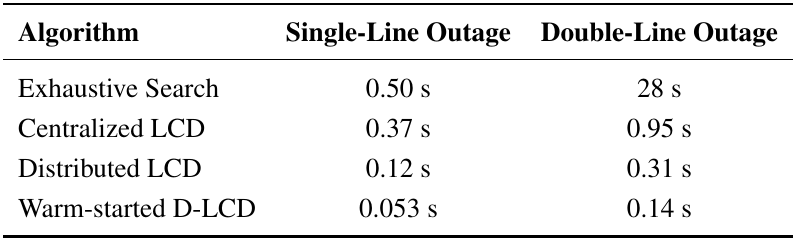
Table 2. Running time comparison for the IEEE 300-bus